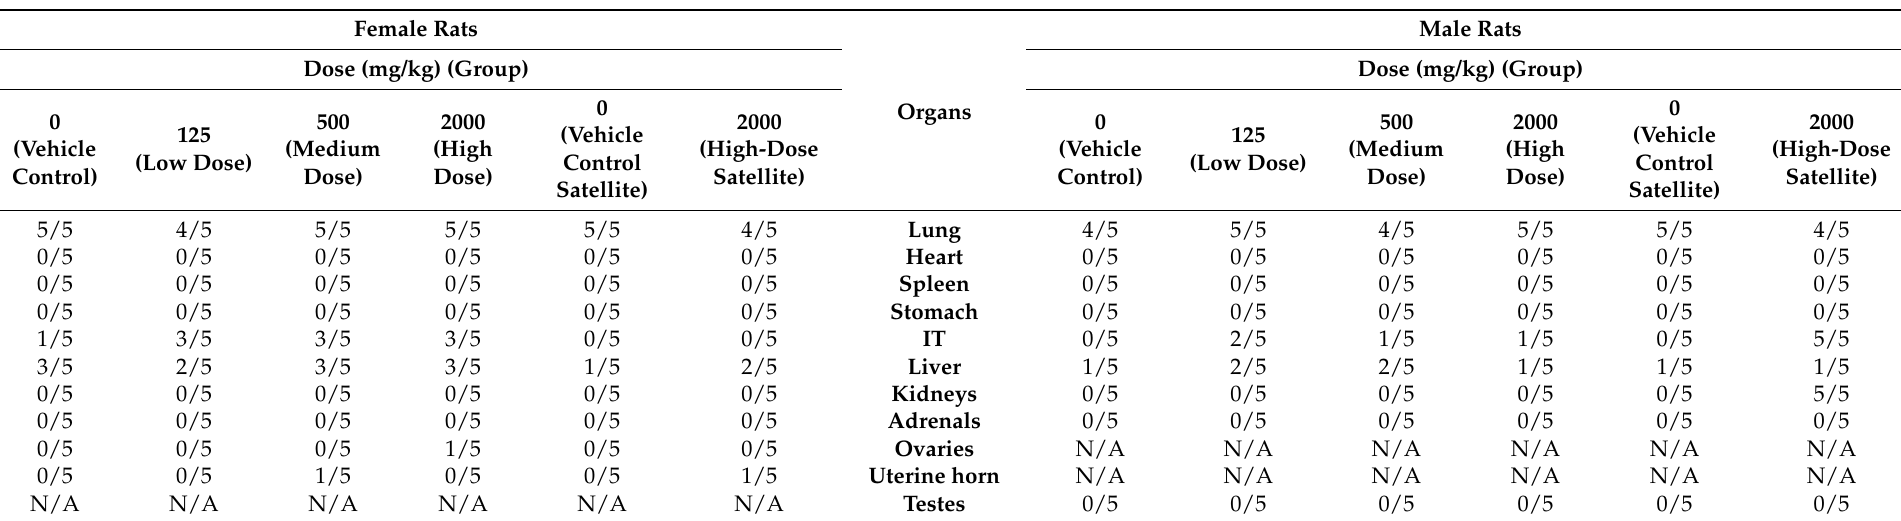
Table 9. Summary of gross pathology findings in female and male